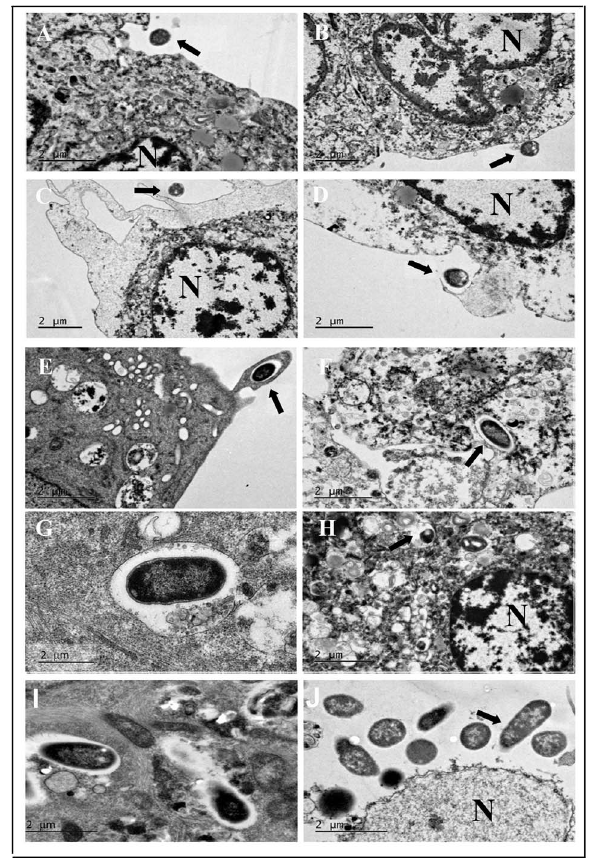
Figure 4. Transmission electron micrographs demonstrating internalization of P.aeruginosa in HMEECs. Epithelial cells were infected with P. aeruginosa for 15 min (A), 30 min (B-E), 1 h (F and G), 8h (H and I), 16h (J), and then subjected to TEM. Results are representative of four independent experiments carried out in triplicate. Arrows indicate bacteria. N: Nucleus. Scale bars 2 m